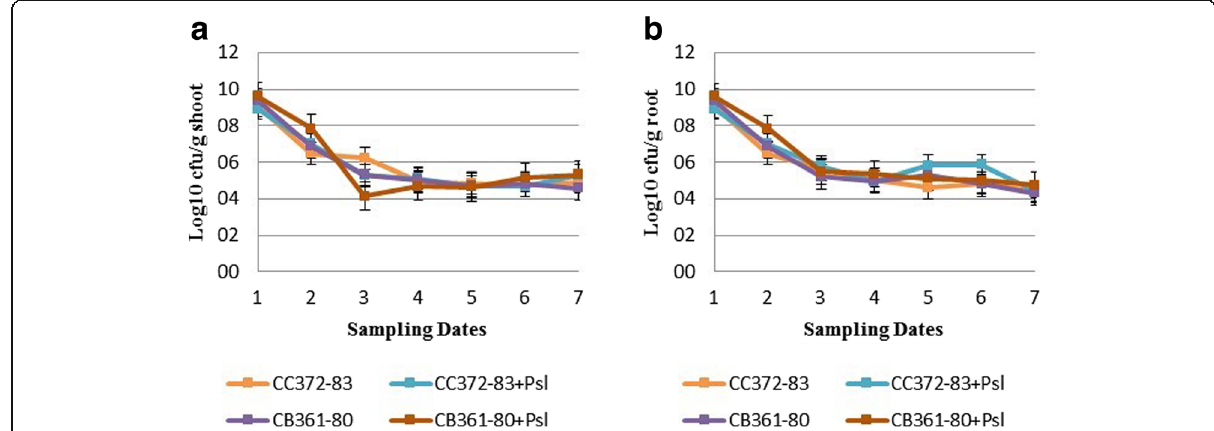
Fig. 2 a Endophytic colonization of isolates CB361-80 and CC372-83 in cucumber plant tissues (shoot) (either not inoculated or inoculated with Pseudomonas syringae pv. lachrymans ) at different sampling dates according to ( Table 2). The population data for graphs were transformed to log (CFU/g). b Endophytic